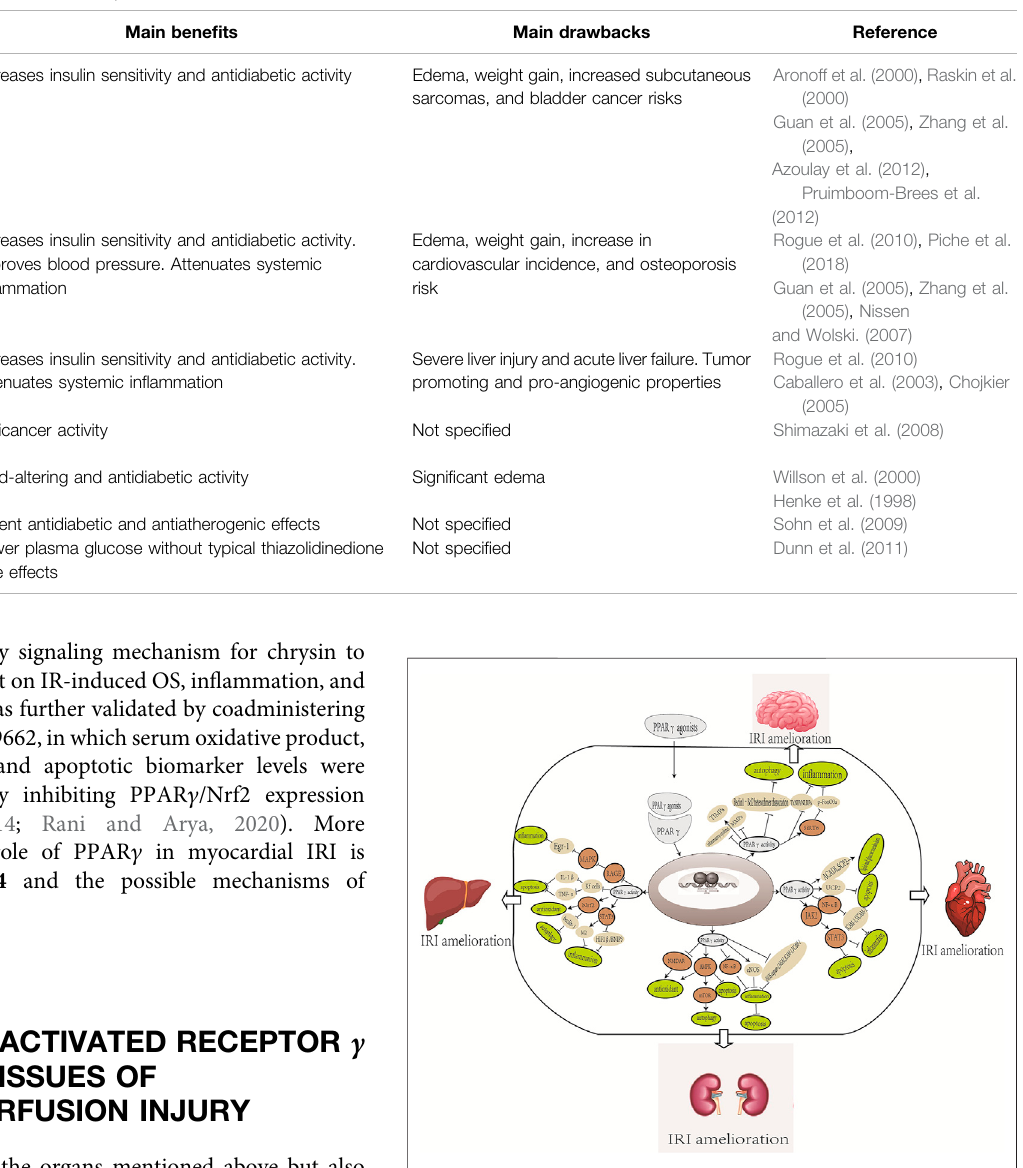
TABLE 5 | Main PPAR γ agonists and their therapeutic bene fi ts vs. drawbacks.